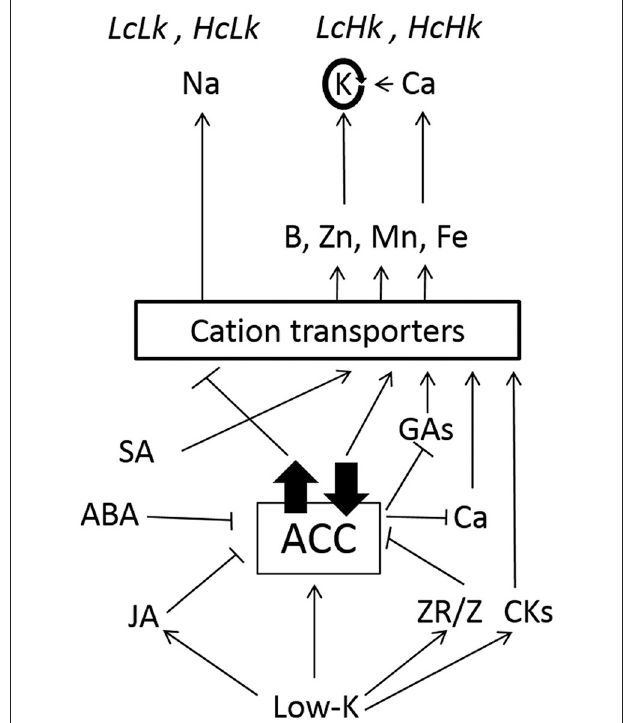
FIGURE 7 | Hormonal and nutritional interactions explaining rootstock-mediated responses to low-K supply. High constitutive or induced ACC levels would favor a higher transport of Na vs. K, probably in mediating HKT transporters in LcLk , HcLk plants. Reduced Z and increased ZR/Z would contribute to decrease ACC in LcHk plants, thus decreasing the impact on GAs and Ca levels and improving K, B, Zn, Mn, and Fe nutrition. High constitutive SA, ABA or induced JA and CKs would contribute to low ACC activity (metabolism and/or signaling) and improved macro and micronutrition in HcHk plants. Arrow or bar heads indicate positive and negative regulation,